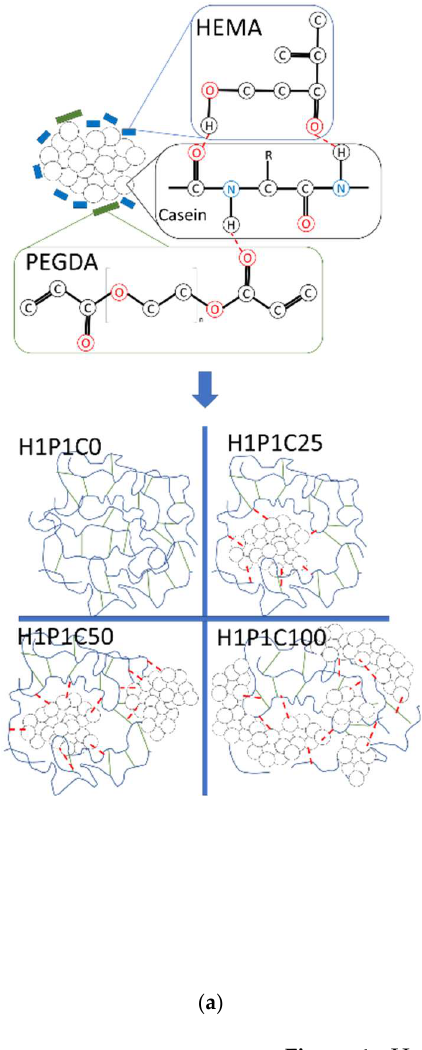
Figure 1. Hybrids synthesis. ( a ) Schematic representation of the hybrids synthesis: Casein (C) micelles dispersed in HEMA (H)-PEGDA (P) polymerisation mixture, with a molar ratio of 4:1. Hydrogen-bond formation between Casein and co-monomers (red dotted line); polymerisation products: synthetic copolymer H1P1C0 and casein-loaded hydrogels with increasing protein content H1P1C25, H1P1C50, H1P1C100; ( b ) from top to down: whole range FT-IR spectra of the hybrids with different casein content; FT-IR spectral details of 2 representative domains: 3800-2500 cm −1 and 1800-800 cm −1 . Casein and H1P1C0 are used as control samples. The presence of casein in the hybrid hydrogels induced some spectral modification.